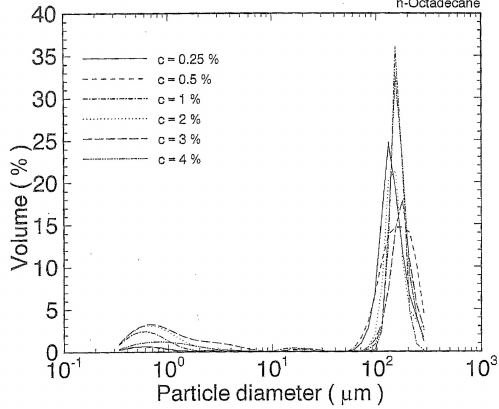
Figure 4. Suspension particle size